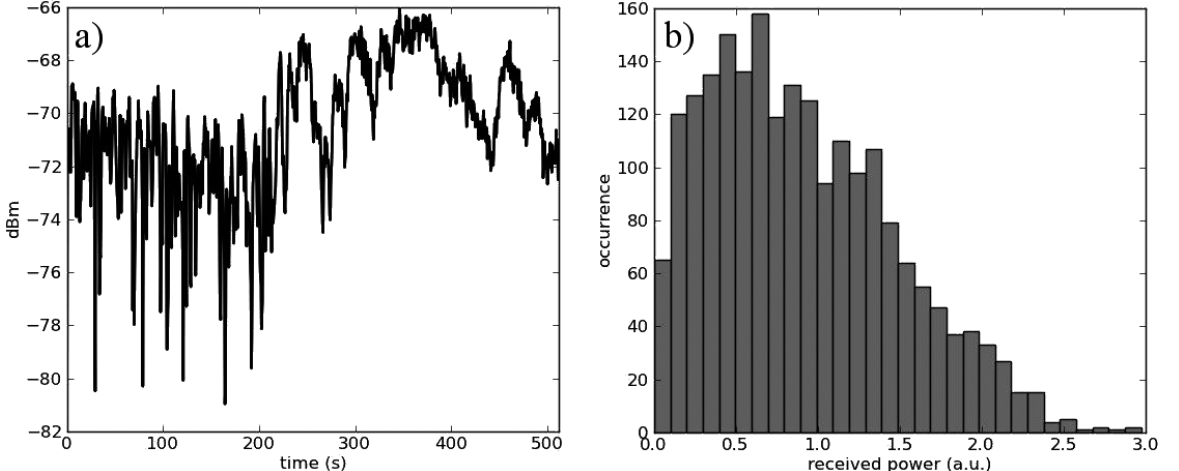
Figure 6. (a) Power observations of the radio echo reflected from the ionosphere on January 7, 2008, at 19:55 UT; (b) corresponding mixed behavior Rayleigh -Nakagami-Rice probability density